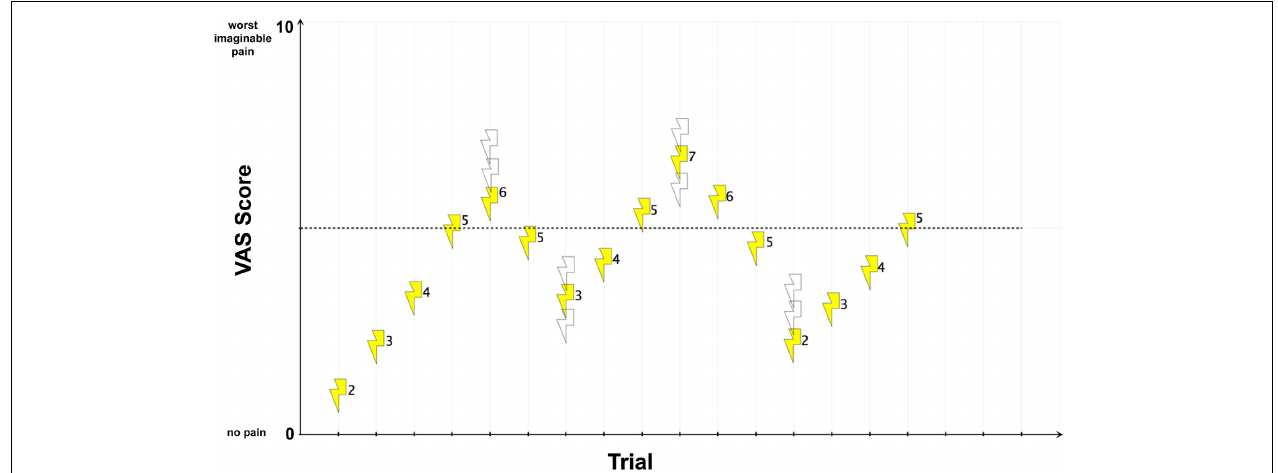
FIGURE 3 | UCS pain intensity and quality matching. For illustration, exemplary electric current strengths (mA-values) are shown next to each stimulus. In this example, an electric current strength of 5mA